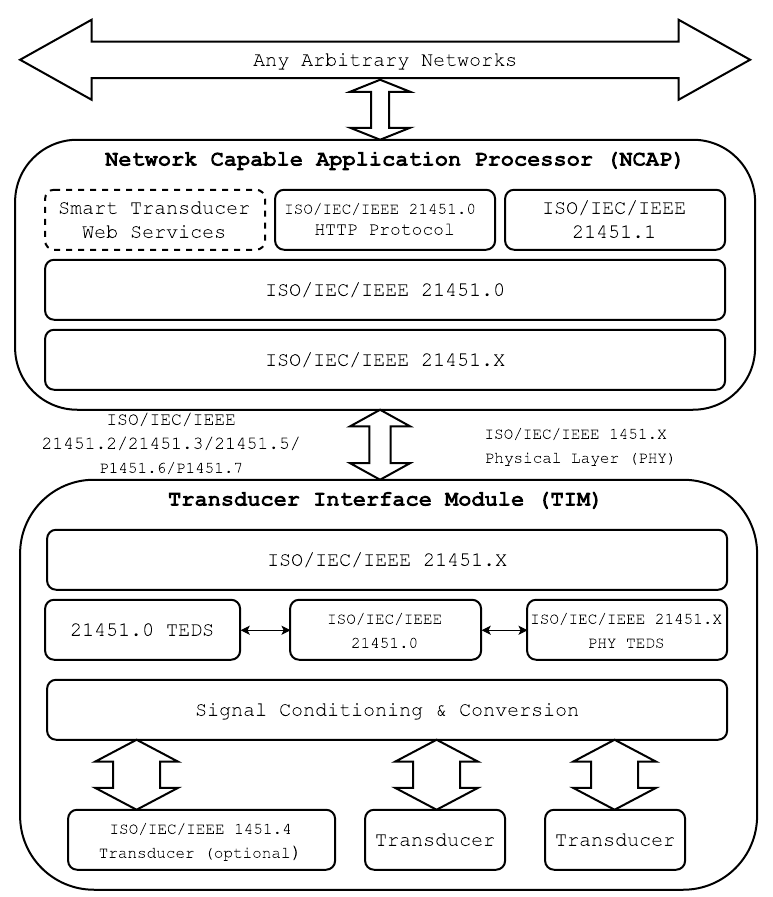
Figure 1. ISO/IEC/IEEE 21451